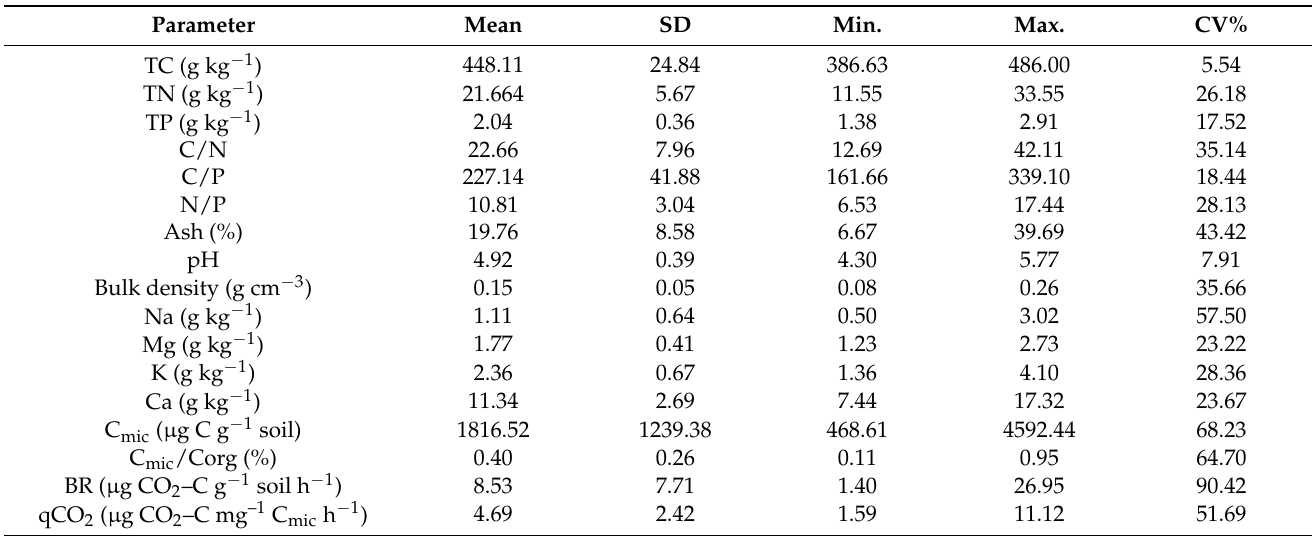
Table 1. Soil properties and microbial respiration activities of all samples as mean, standard deviation, and coefficients of variation (in percentage: